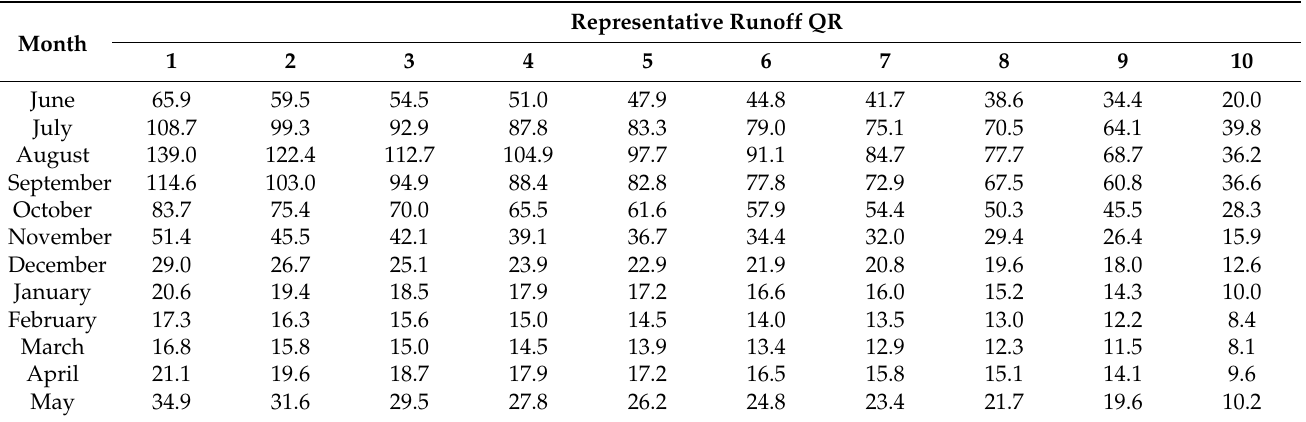
Table 4. Representative flow in each month for simulated runoff of the NZD hydropower plant (10 8 m 3 ).